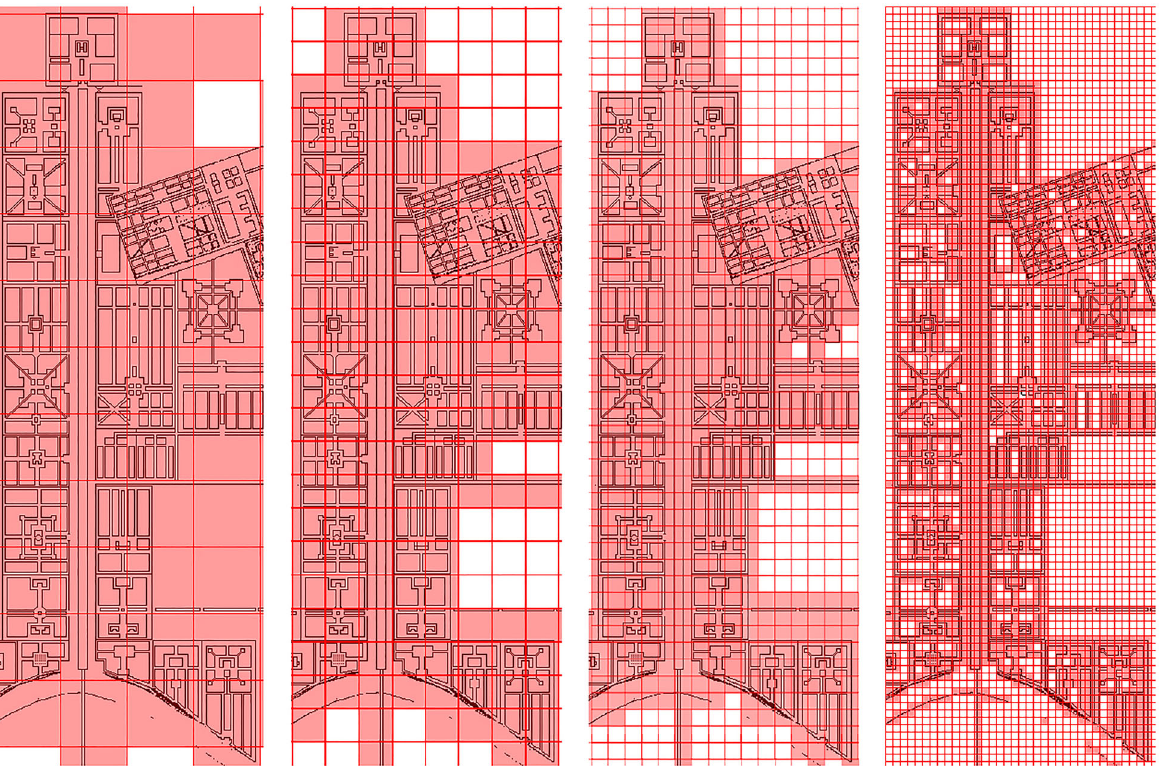
Fig. 6 A diagrammatic illustration of the Box-Counting Method applied to Isfahan garden city plan. Four successive grids are applied to range from l = 73 to l = 18, where l is the length of the sides of the boxes (in pixels). This illustration does not show the grid rotation and the random placements of grids effectively carried out by the software BENOIT TM version